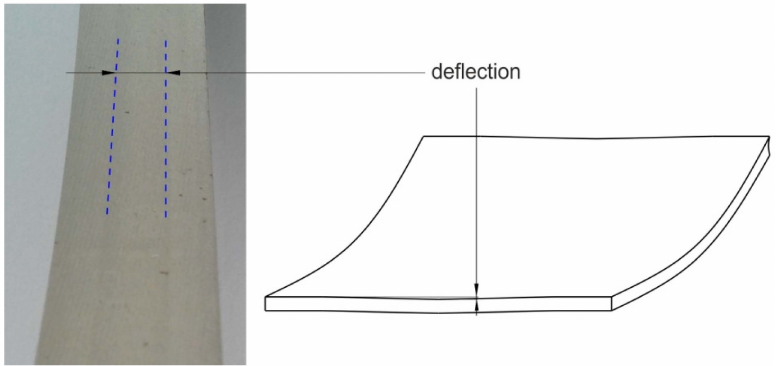
Figure 9. Deflection of the sheet strip ( w = 20 mm) after passing the